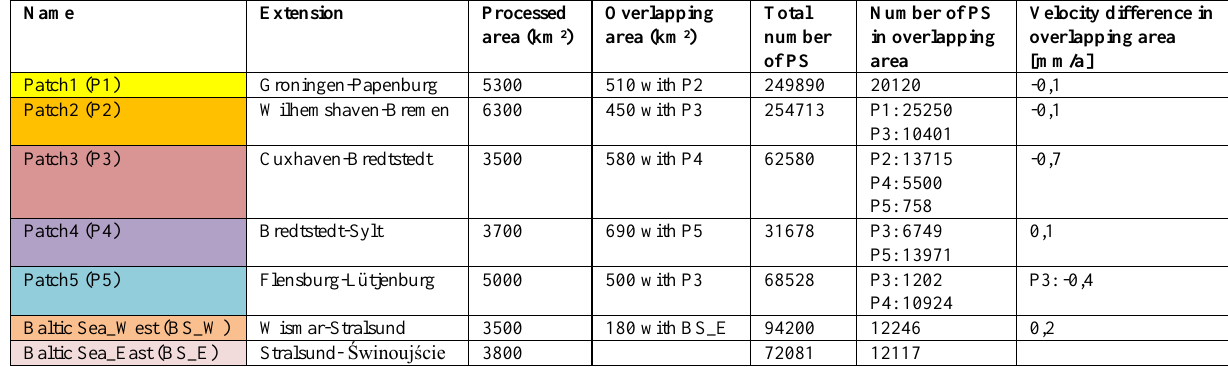
Table 1: Overview of size and number resulting PS related to processed